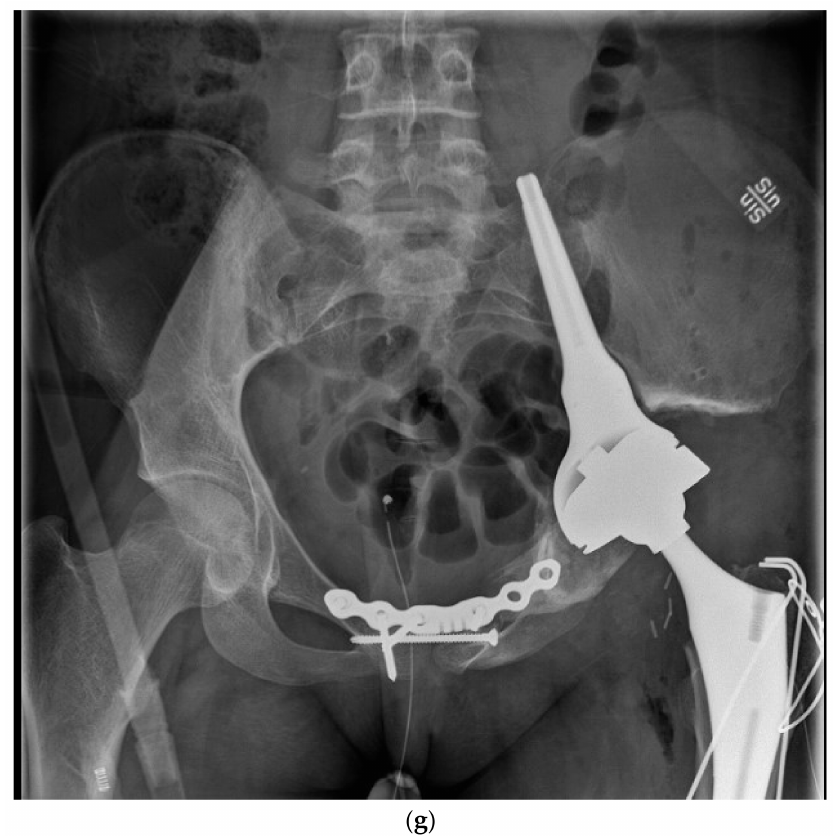
Figure 2. Surgical failure of biological reconstruction after major pelvic surgery, salvaged with endoprosthesis. ( a , b ) A previously healthy 15-year old girl with 1-year history of left-sided groin pain. MRI of the pelvis (T1 TIRM coronal ( a ) and axial ( b ) images) showing a bone tumor involving the left superior ramus of the pubic bone and the periacetabular region of the iliac bone. There is a soft tissue component engaging the obturator internus-externus and adductor muscle. Staging procedures did not show any evidence of metastatic disease. Fine-needle aspiration showed a monotonous small round blue-cell tumor most likely representing Ewing sarcoma. FISH analysis showed an EWSR1-Fli1 fusion transcript confirming the Ewing sarcoma diagnosis. ( c , d ) After induction chemotherapy with VIDE (vincristine, ifosfamide, doxorubicin, and etoposide), the soft tissue component, as well as the intraosseous extension of the tumor, was significantly reduced, as shown on the coronal ( c ) and axial ( d ) T2 TSE FS MRI images. ( e ) The patient underwent a P2/P3 internal hemipelvectomy, extra-corporeal irradiation with 55 Grey and re-implantation of the autograft. ( f , g ) One year after primary surgery, the autograft collapsed ( f ), requiring salvage reconstruction with the Mutars Lumic Cup ( g ). A year later, the patient is functioning well and remains free of